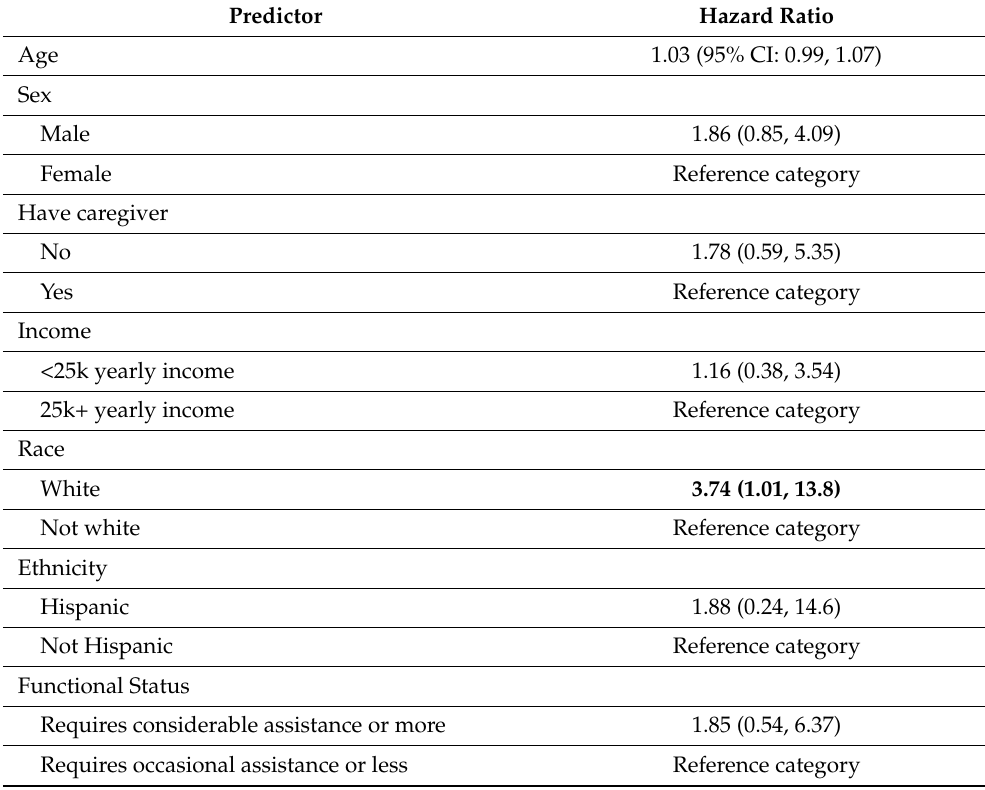
Table 2. Cox Proportional Hazards Model to examine the relationship between baseline characteristics and time to withdrawal from the program ( N =